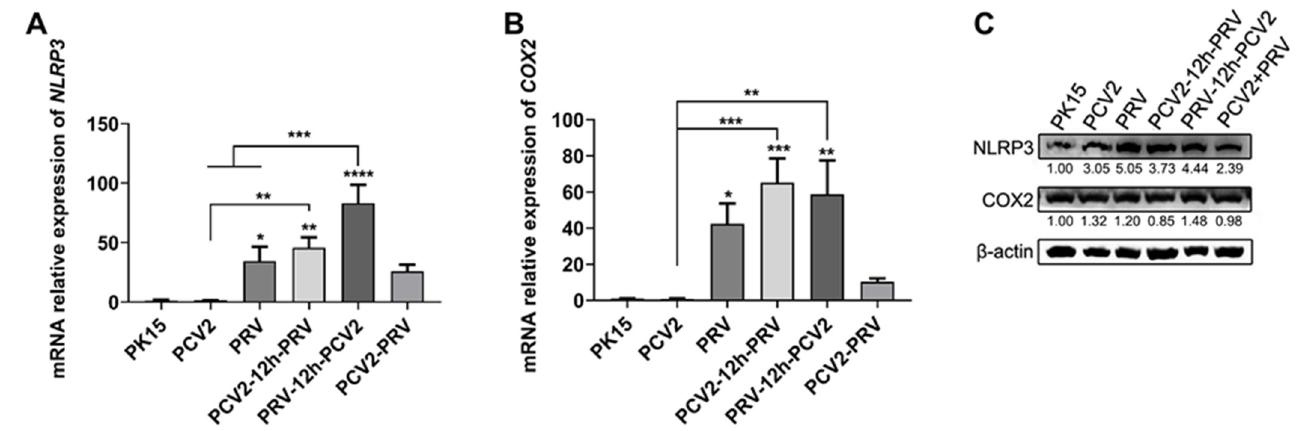
Figure 7. Coinfection of PCV2 and PRV activates the NLRP3 pathway. ( A , B ) Expression levels of NLRP3 and COX2. The relative mRNA levels of NLRP3 ( A ) and COX2 ( B ) were examined via Real-time PCR. The data are presented as the means ± SD. *, p -value < 0.05; **, p -value < 0.01; ***, p -value < 0.001; ****, p -value < 0.0001. ( C ) Protein levels of NLRP3 and COX2. Western blotting was performed using NLRP3, Cox-2, and Anti- β -Actin Antibody as primary antibodies, respectively. HRP-labeled Goat Anti-mouse IgG (H+L) and HRP-labeled Goat Anti-rabbit IgG (H+L) were used as the secondary antibody. β -actin was used as a control. The average expression level of the target protein in each group is shown below each lane. The protein amount of the PK-15 group is set to 1, and the values of other groups are the ratio with the PK-15 group. Unprocessed original images can be found in Supplementary Figure S6.